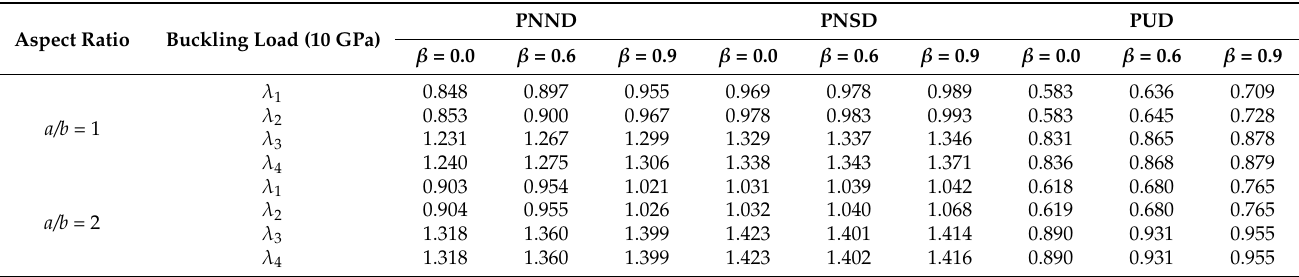
Table 8. First four shear buckling loads for a FCFC FG-saturated porous plate with different aspect ratios, a / b , porosity distributions and Skempton coefficients, β , while keeping e 0 = 0.6 fixed.